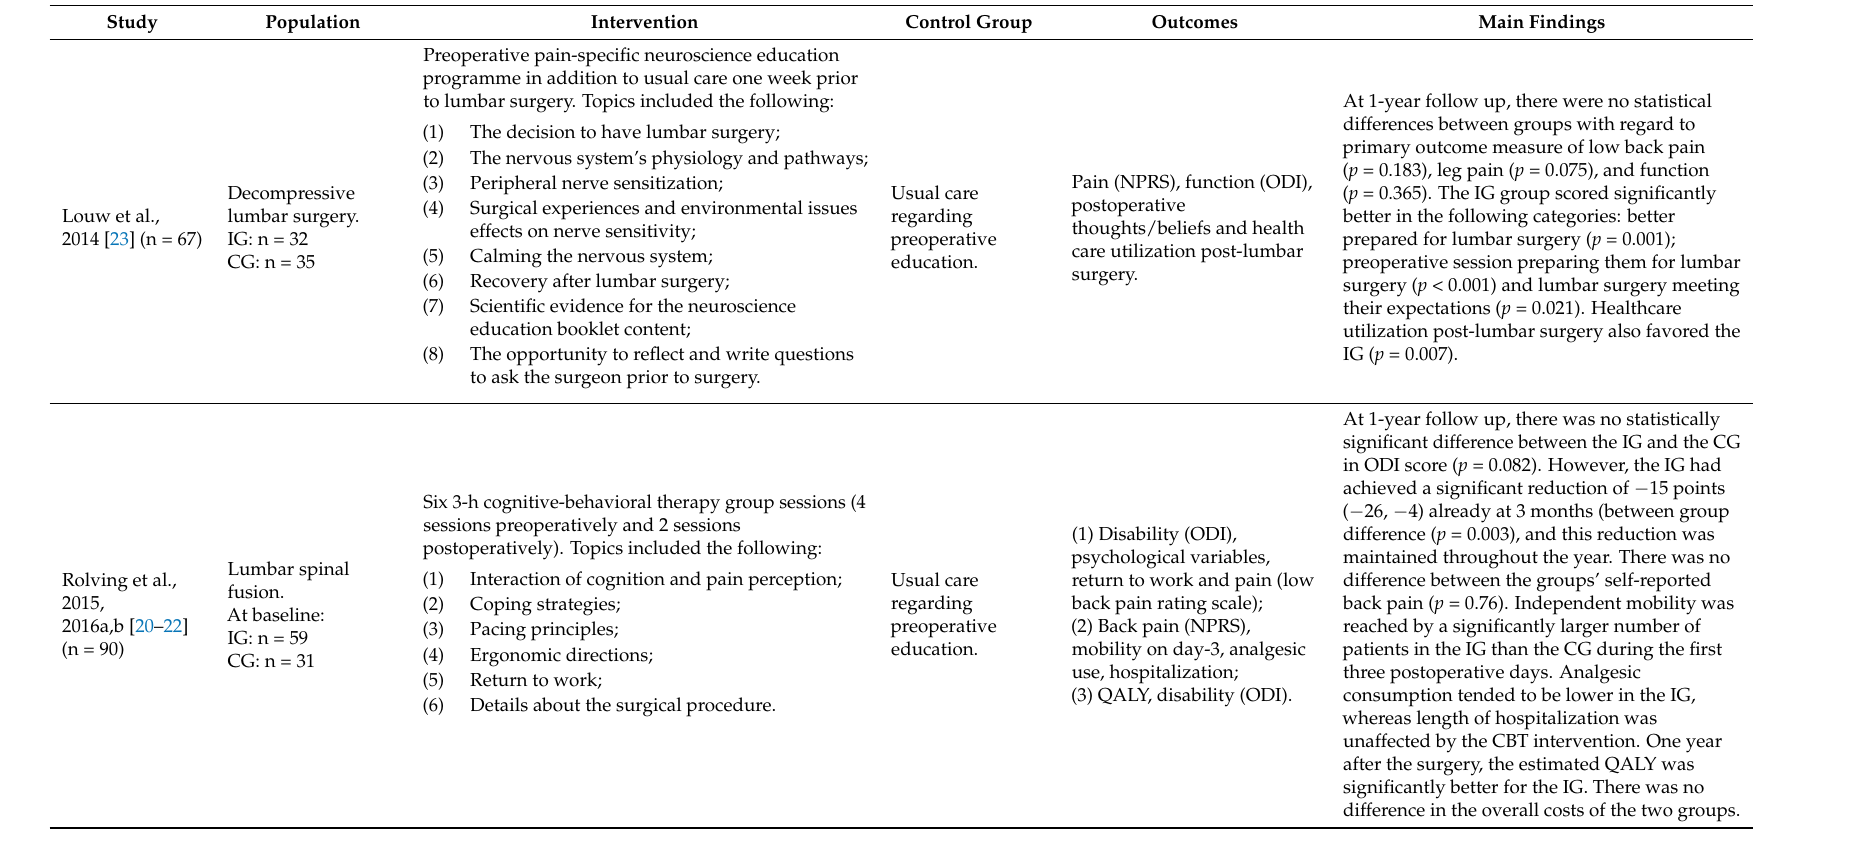
Table 3. Summary of preoperative education interventions for spine